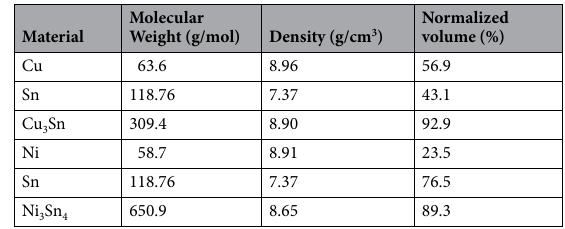
Table 2. The volume ratio during the following reactions: 3 Cu + Sn → Cu 3 Sn and 3 Ni + 4 Sn → Ni 3 Sn 4 . The normalized volume is the volume of elements (compounds) normalized to the initial total volume.